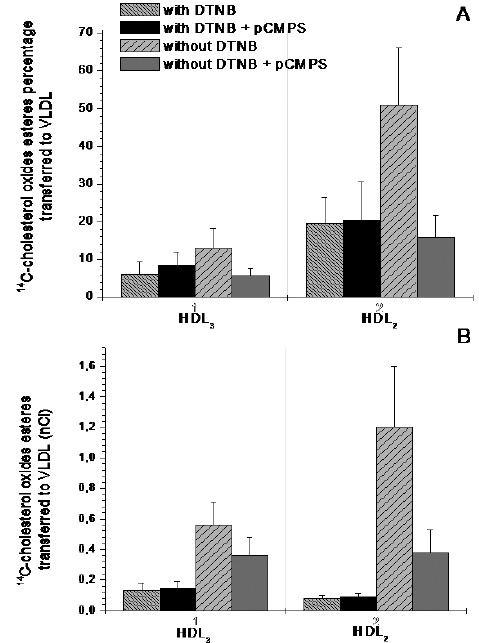
FIGURE 4 - Transfer of 14 C-cholesterol oxide esters from HDL and HDL to VLDL, (A) in % of 14 C-cholesterol transferred and 2 (B) in nCi. Both with DTNB, with DTNB plus pCMPS , without DTNB and without DTNB plus